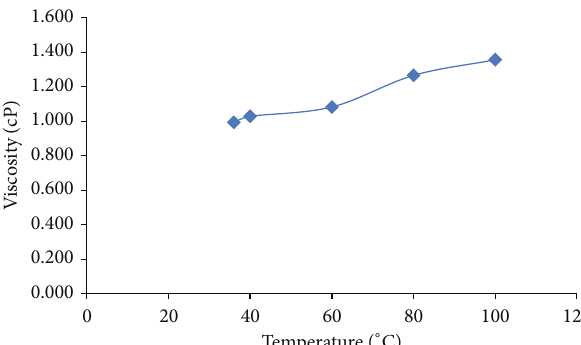
Figure 2: Effect of temperature on viscosity of S. tora gum.